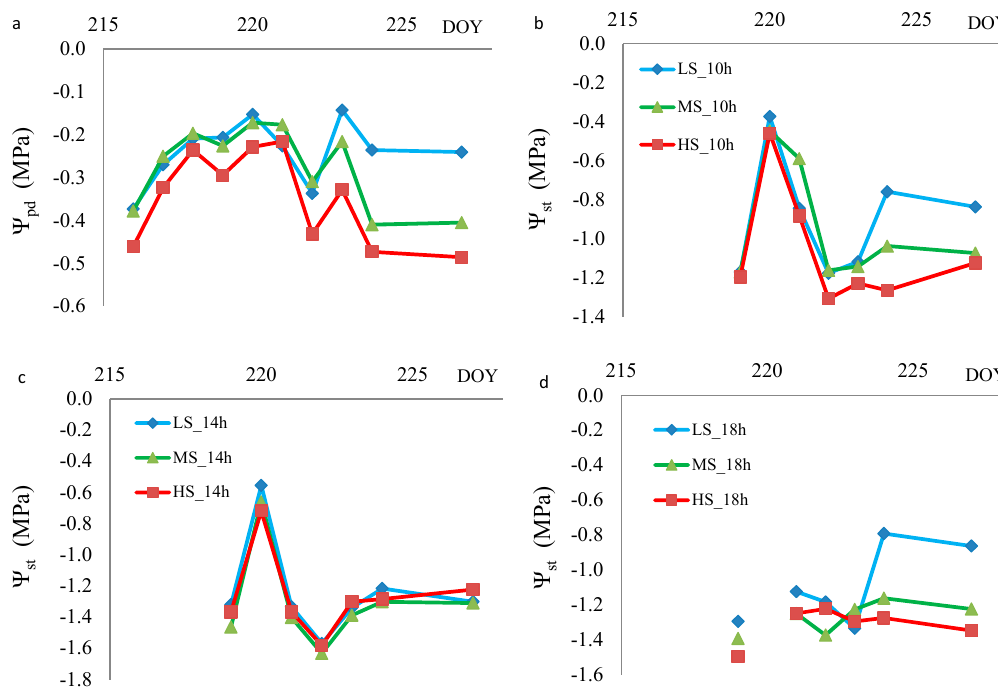
Figure 2. Observed Ψ pd ( a ) and Ψ st of grapevines at 10:00 a.m. ( b ); 2:00 p.m. ( c ) and 6:00 p.m. ( d ) (solar noon at ≈ 1:45 p.m.) for the treatments described (Low Stress, Medium Stress and High Stress, see text) immediately before and during the 2010 stress cycle (8th to 16th August 2010). Irrigation events during the stress cycle: see text. The standard deviations of means are within symbol width. Vineyard (Beja, Portugal).